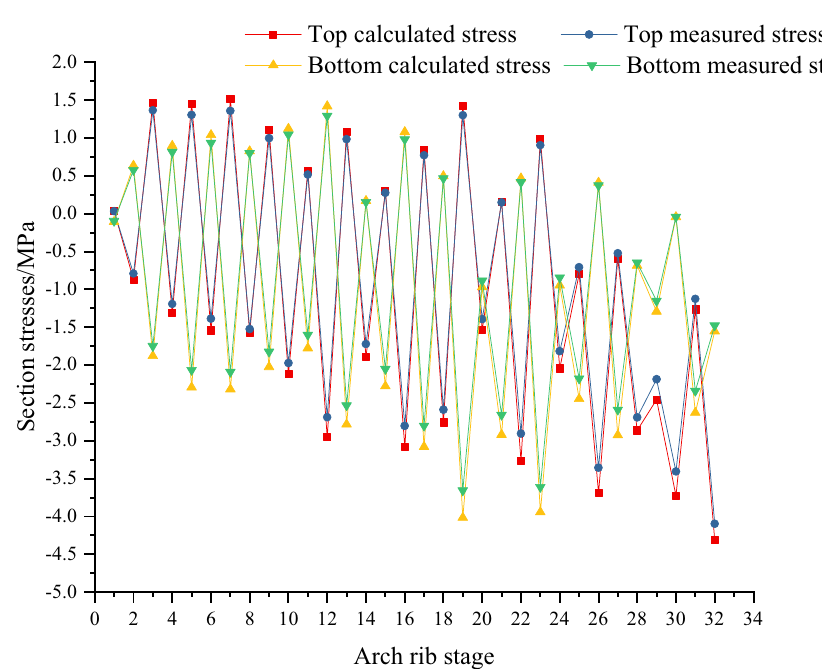
Figure 23. Calculated and measured stresses of key section No. 1 (arch foot) in the process of arch rib